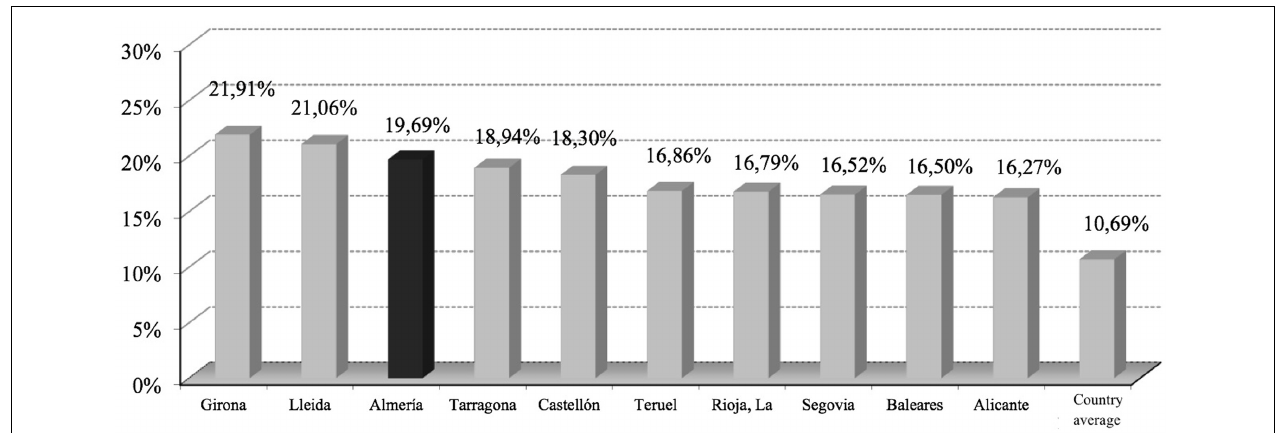
FIGURE 3 | Provinces with greater weight of under 16 foreigners on the total population of that age group (2014). Source : INE.